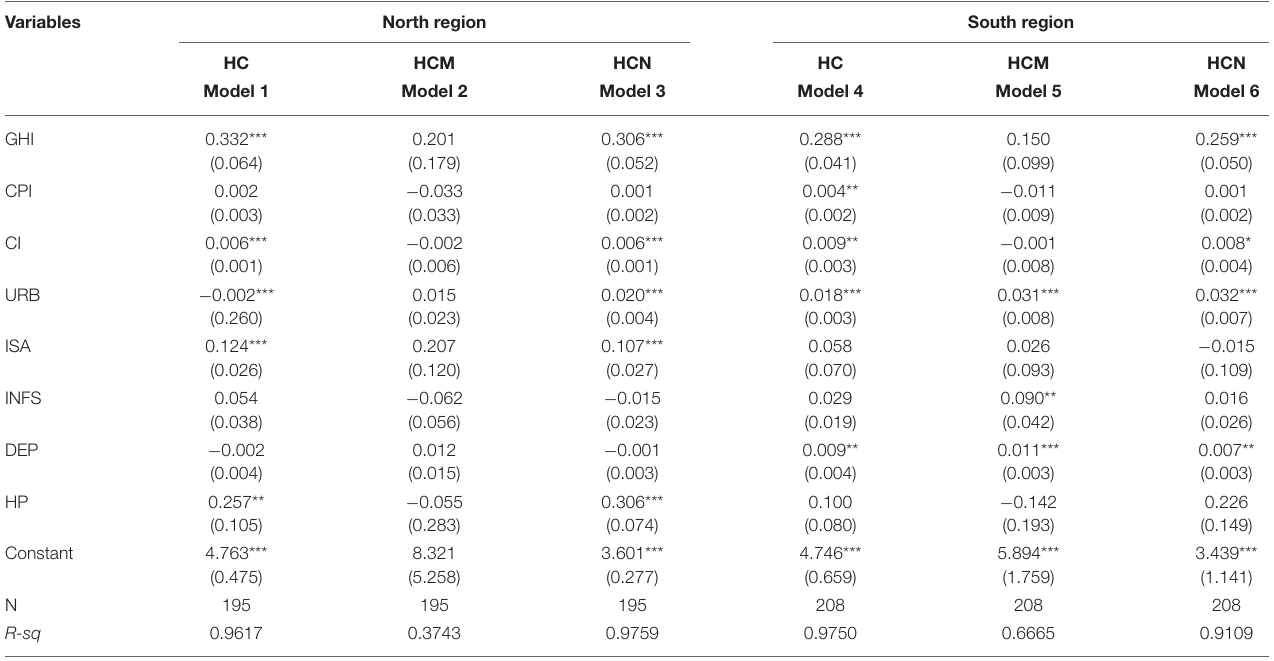
TABLE 5 | Heterogeneity analysis of different economic regions sample.